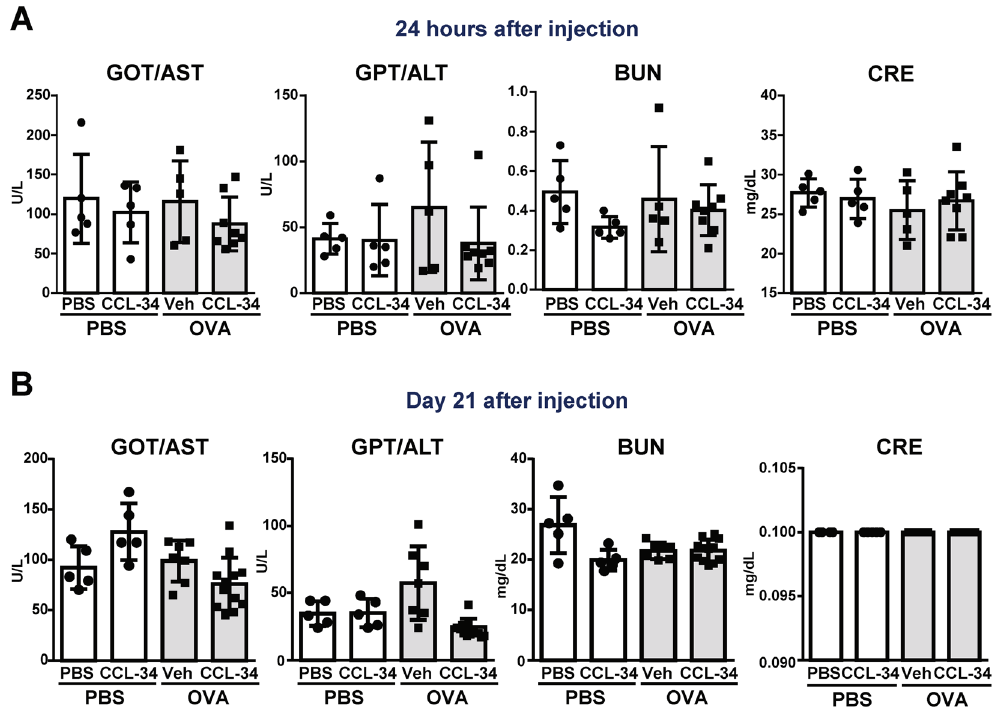
Figure 6. CCL-34 treatment did not cause cytotoxicity in C57BL/6 mice at early and late stages. (A) The toxicity index of CCL-34 at early stage. C57BL/6 mice were immunized with PBS or OVA (100 μ g/mouse) formulated with vehicle (10% DMSO) or CCL-34 (4 mg/kg). The serum was collected 24 hours after injection, and then analyzed for the biochemical markers such as GOT, GPT, BUN, and CRE. (B) The toxicity index of CCL-34 at late stage. C57BL/6 mice were immunized with PBS or OVA (100 μ g/mouse) formulated with vehicle (10% DMSO) or CCL-34 (4 mg/kg) on days 0, 7 and 14. The serum was collected on day 21 and then analyzed for the cytotoxic indexes such as GOT, GPT, BUN, and CRE. The results were plotted using GraphPad Prism version 8.1.0